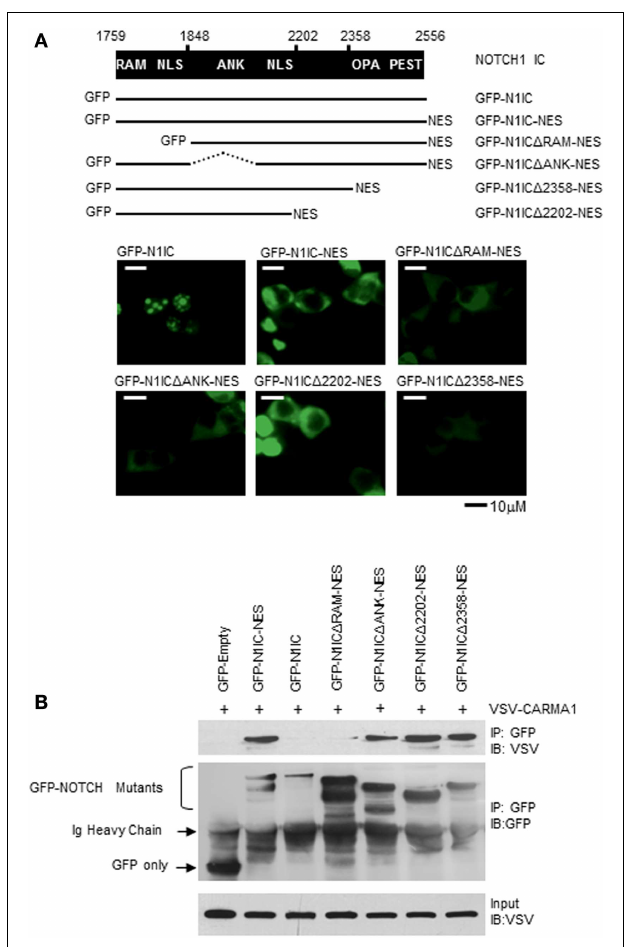
FIGURE 6 |The RAM domain of NOTCH1 mediates its interaction with CARMA1 . (A) GFP–N1IC mutant expression plasmids were transfected into 293T cells and sub-cellular localization of NOTCH1 was examined using fluorescence microscopy. (B) VSV–CARMA1 expression plasmids were transiently co-transfected with GFP empty vector as a control, or with GFP–N1IC mutant plasmids in 293T cells, as indicated.Transfected cells were harvested and cell lysates were co-immunoprecipitated with antibodies specific for GFP. Co-immunoprecipitated proteins were then immunoblotted with anti-VSV or anti-GFP. Ig heavy chain indicates immunoglobulin heavy